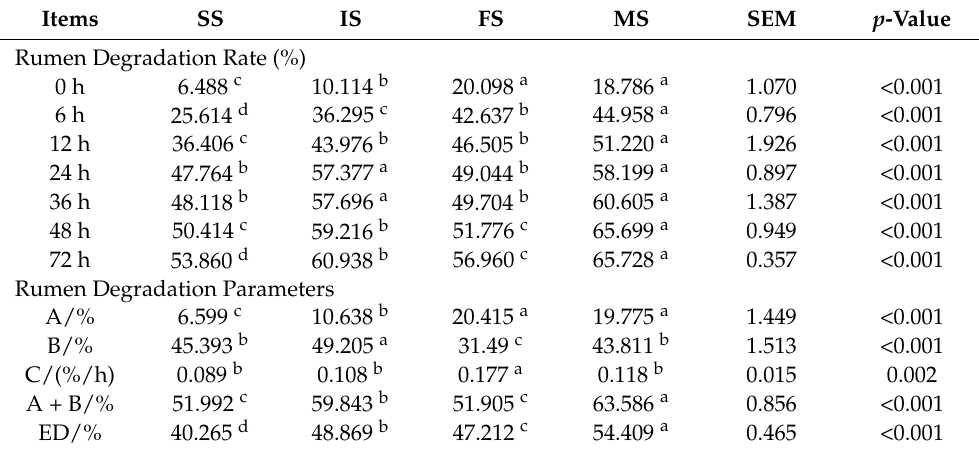
Table 6. Rumen ADF degradation characteristics of Amaranthus hypochondriacus hay.